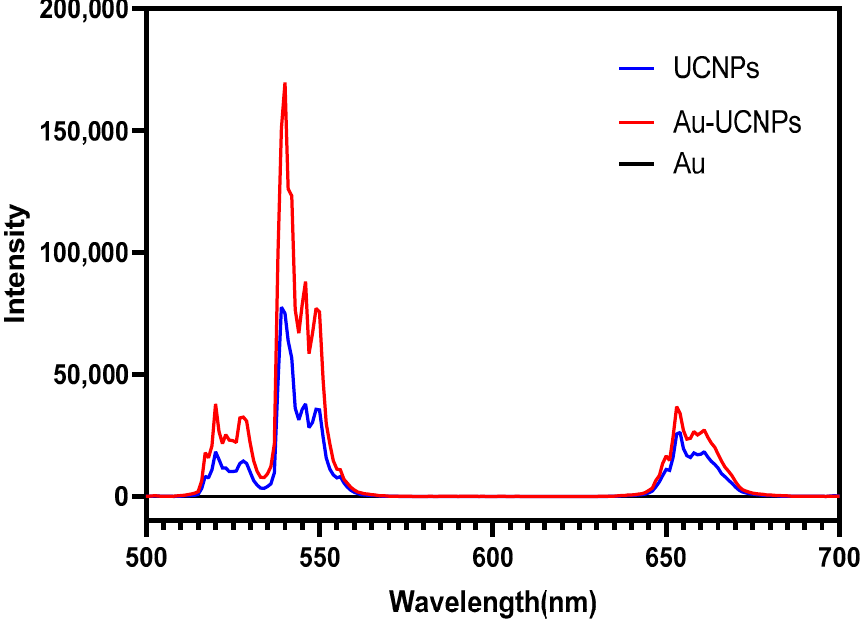
Figure 2. Luminescent intensity of UCNPs (blue), Au (black), and Au-UCNPs (red). The emission bands observed at 409 nm (purple), 524 nm, 543 nm (green), and 655 nm (red) are due to the transitions of Er 3+ ions such as 2 H 9/2 → 4 I 15/2 , 2 H 11/2 → 4 I 15/2 , 4 S 3/2 → 4 I 15/2 , and 4 F 9/2 → 4 I 15/2 , respectively (Figure 3). However, it is observed that the red and green emissions become more prominent than the purple emission which might be attributed to the cross-relaxation process from 2 G 7/2 to 2 H 9/2 levels. Furthermore, purple, green, and red lights exhibit varying degrees of enhancement. The SPR absorption peak at 520 nm coincides with the emission band of green light so the SPR vibration frequency overlaps the luminescence band of UCNPs. The coupling of the emitted light and the SPR increases the photon localized state density near the surface of Au, thereby